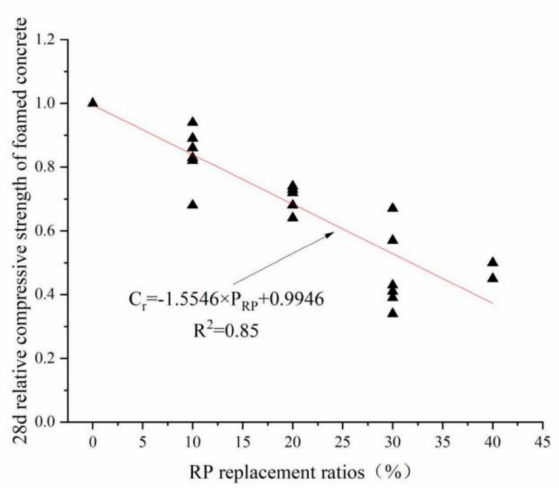
Figure 18. Graph of 28 d relative compressive strength of foamed concrete under different replace- ment rates of RP [46,68,72,78].